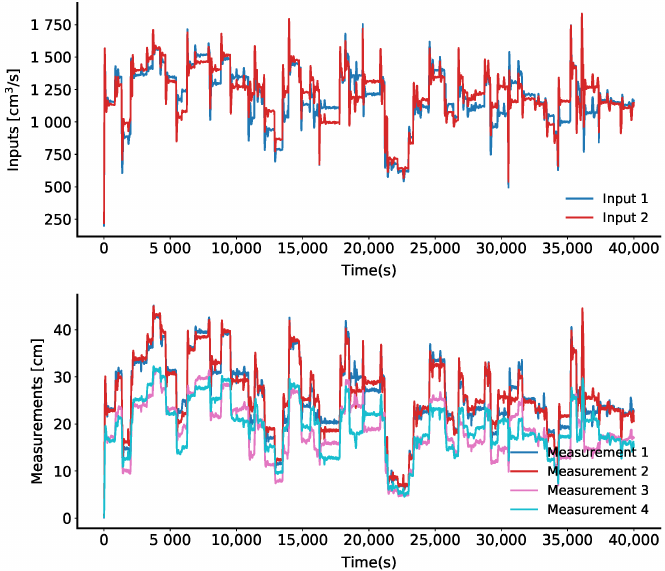
Figure 3. An extract from the data-set of the four tank system. Above: Inputs, Below: